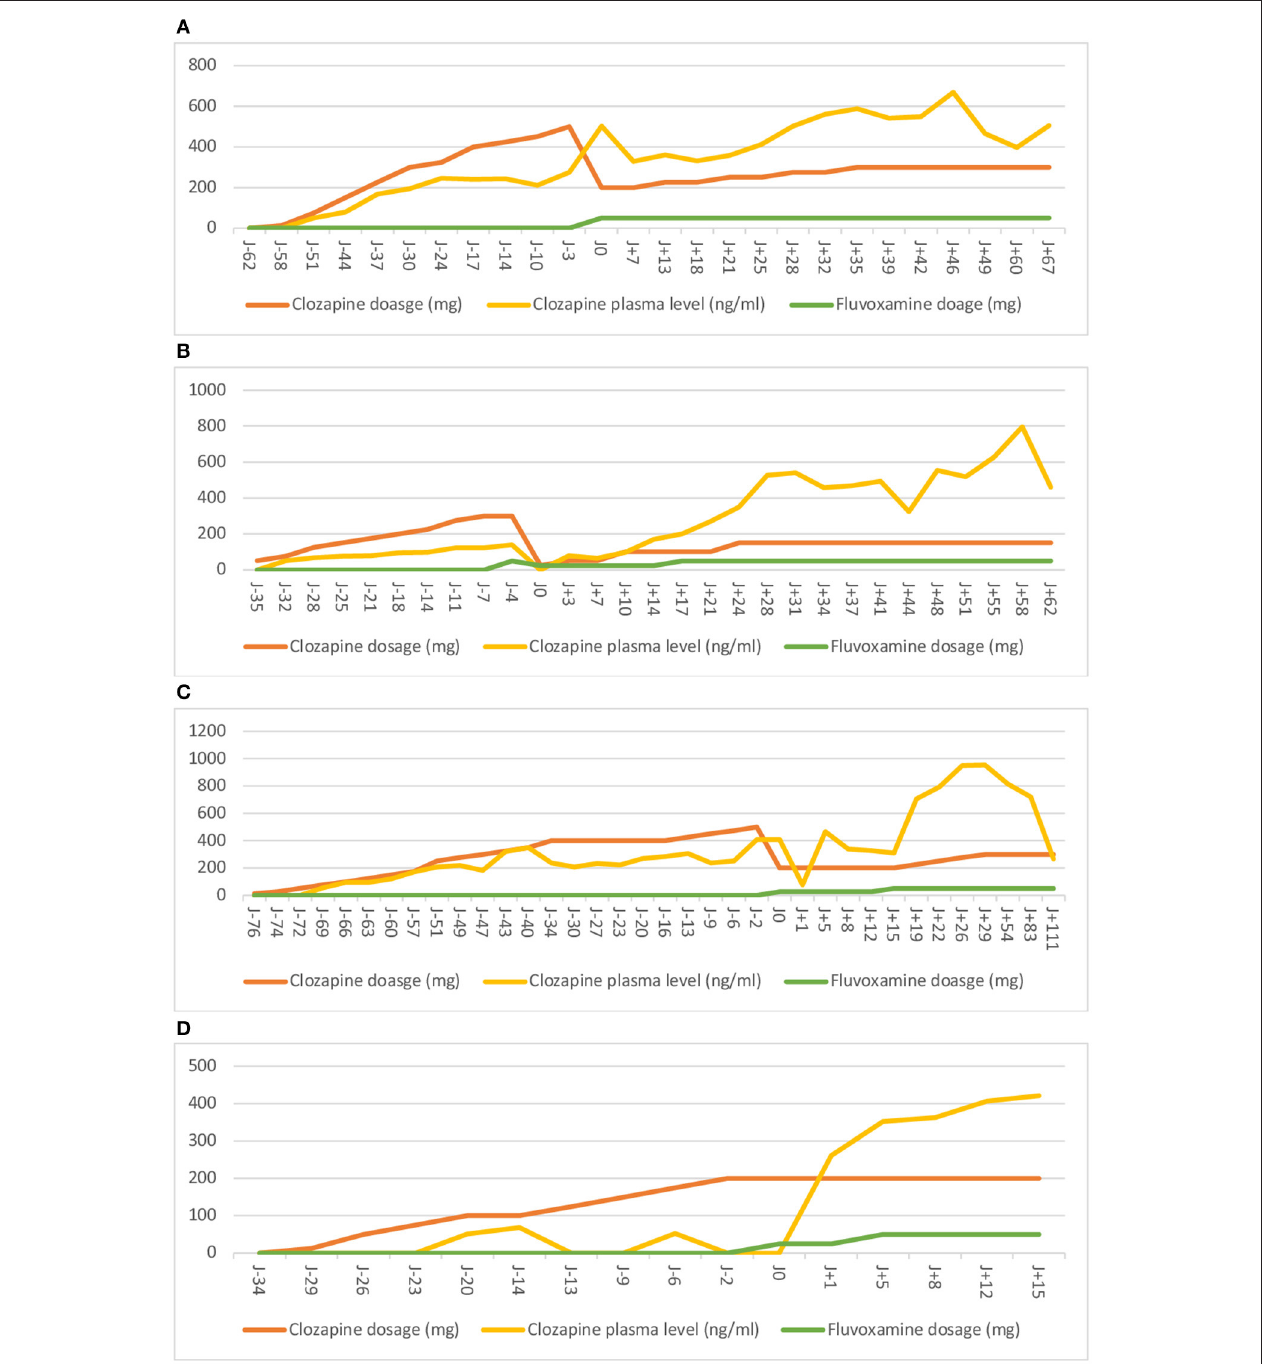
FIGURE 1 | Evolution of clozapine plasma level (ng/mL) for each case. Period of time before and after the introduction of fluvoxamine. J0 represents the day of the introduction of